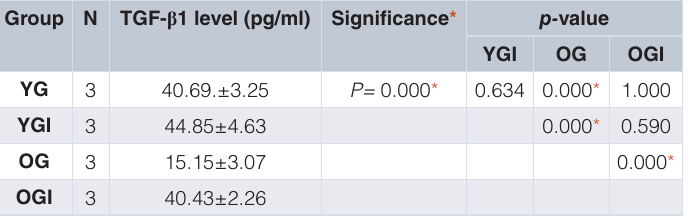
Table 3. Descriptive statistics and results of the Anova and Tukey HSD tests comparing the TGF- β 1 in the 4 groups tested at day 14 after orthodontic appliance